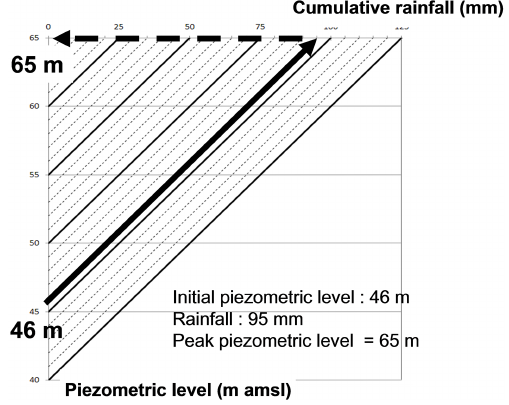
Figure 3. Graphical tool of the piezometric karst level response to different rainfalls (Borrell Estupina et al., 2014). For example, in September 2005, with an initial piezometric level of 46ma.s.l., the first 95mm of rainfall filled the karstic system. The piezometric level increased to 65ma.s.l., which is the threshold for overflow.